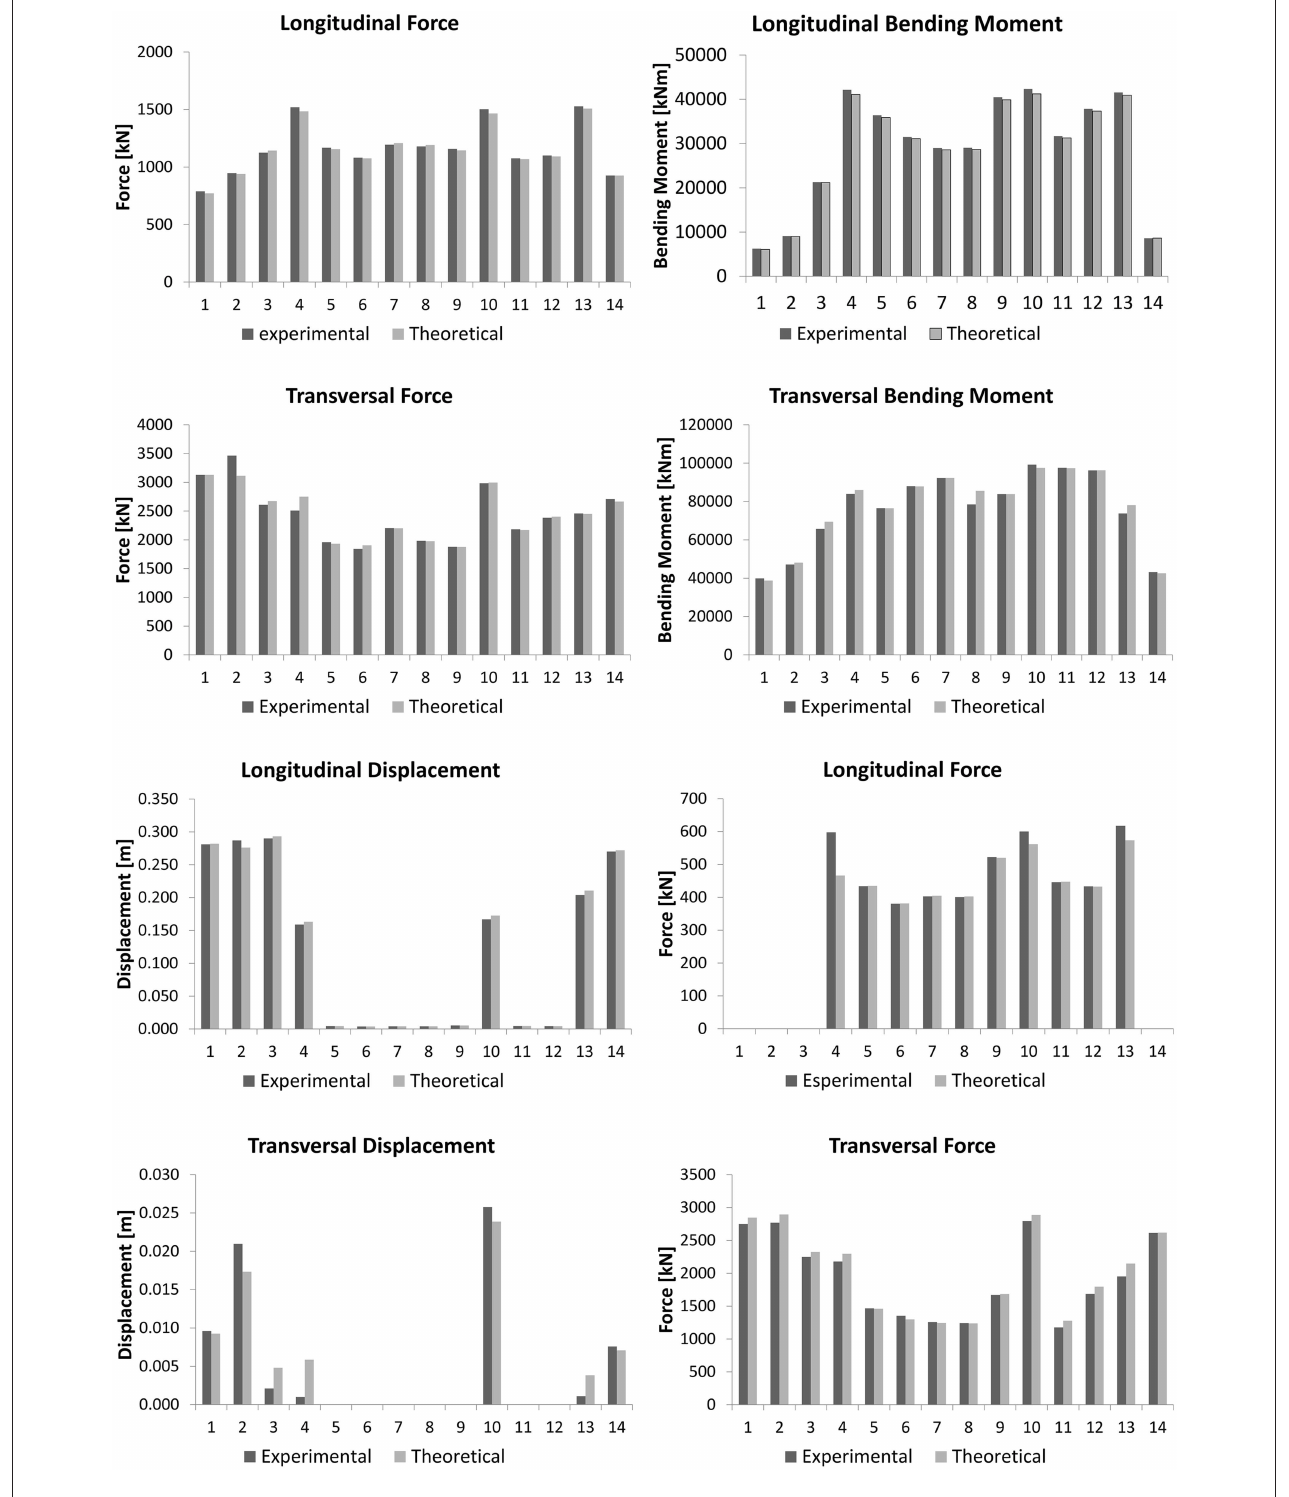
FIGURE 9 | Strength at the base of the piers and force–displacement in the devices.